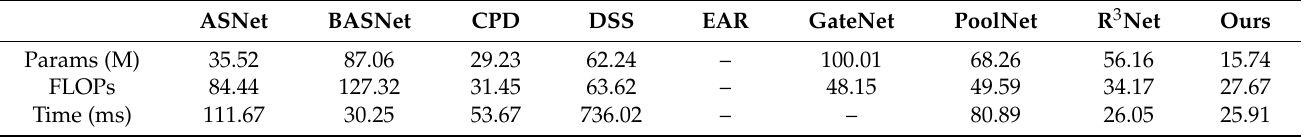
Table 2. Comparison with state-of-the-art methods in terms of model parameters and computational efficiency. The smaller the score of the evaluation index, the higher the computational